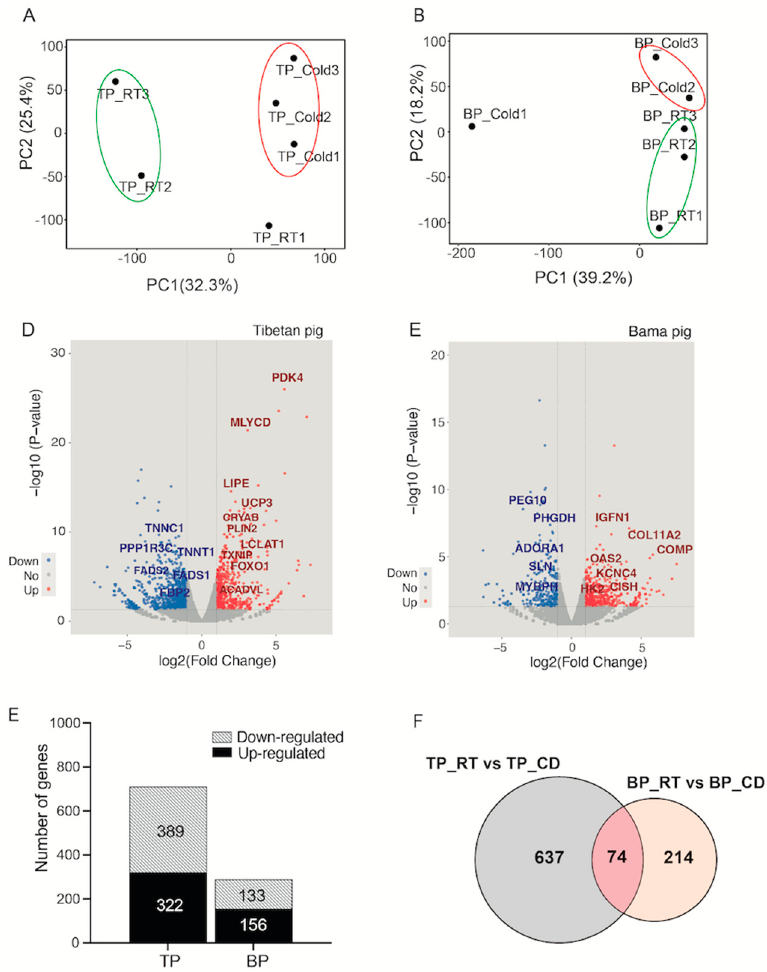
Figure 2. RNA-seq analysis of differential expressed genes (DEGs) in the BF of TP and BP under room temperature (RT) or cold (CD) conditions. ( A , B ) PCA of samples from TP and BP. ( C , D ) Volcano plots showing significance on the y-axis ( − log 10 p -value) plotted against the gene expression ratio (log 2 FC) on the x-axis; the p < 0.05 significance level is indicated by gray dashed horizontal lines. ( E ) The numbers of upregulated (black) and downregulated (striped) DEGs between Tibetan and Bama pigs. ( F ) Venn diagram based on the number of DEGs (FC > 2, p ‒ value < 0.05).